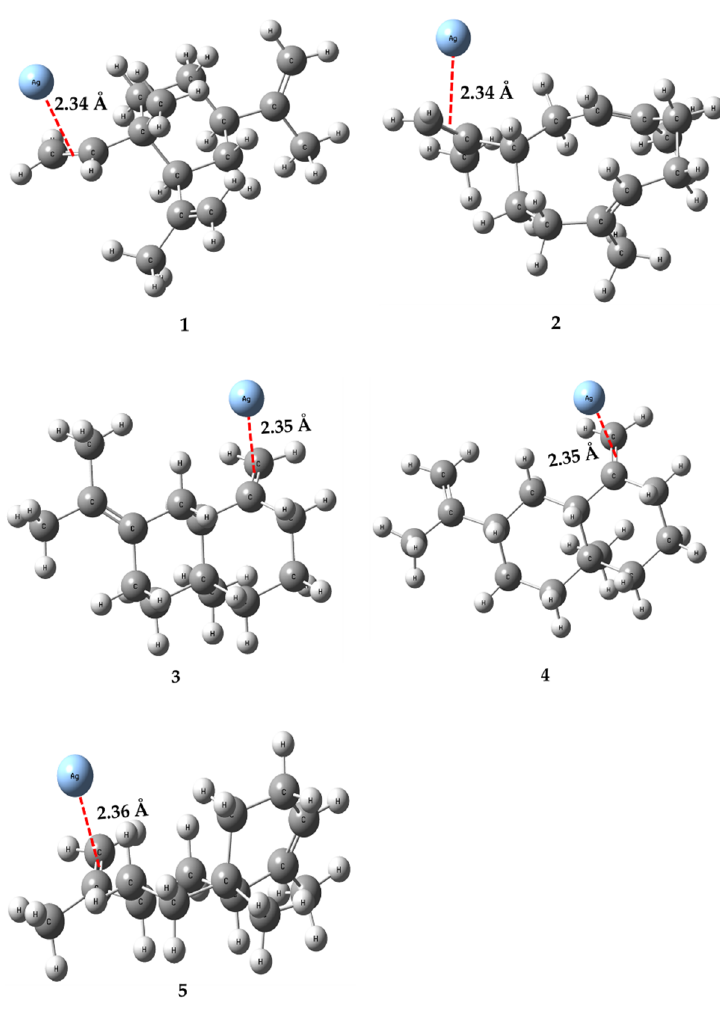
Figure 2. Complexation scheme for compounds 1 – 5